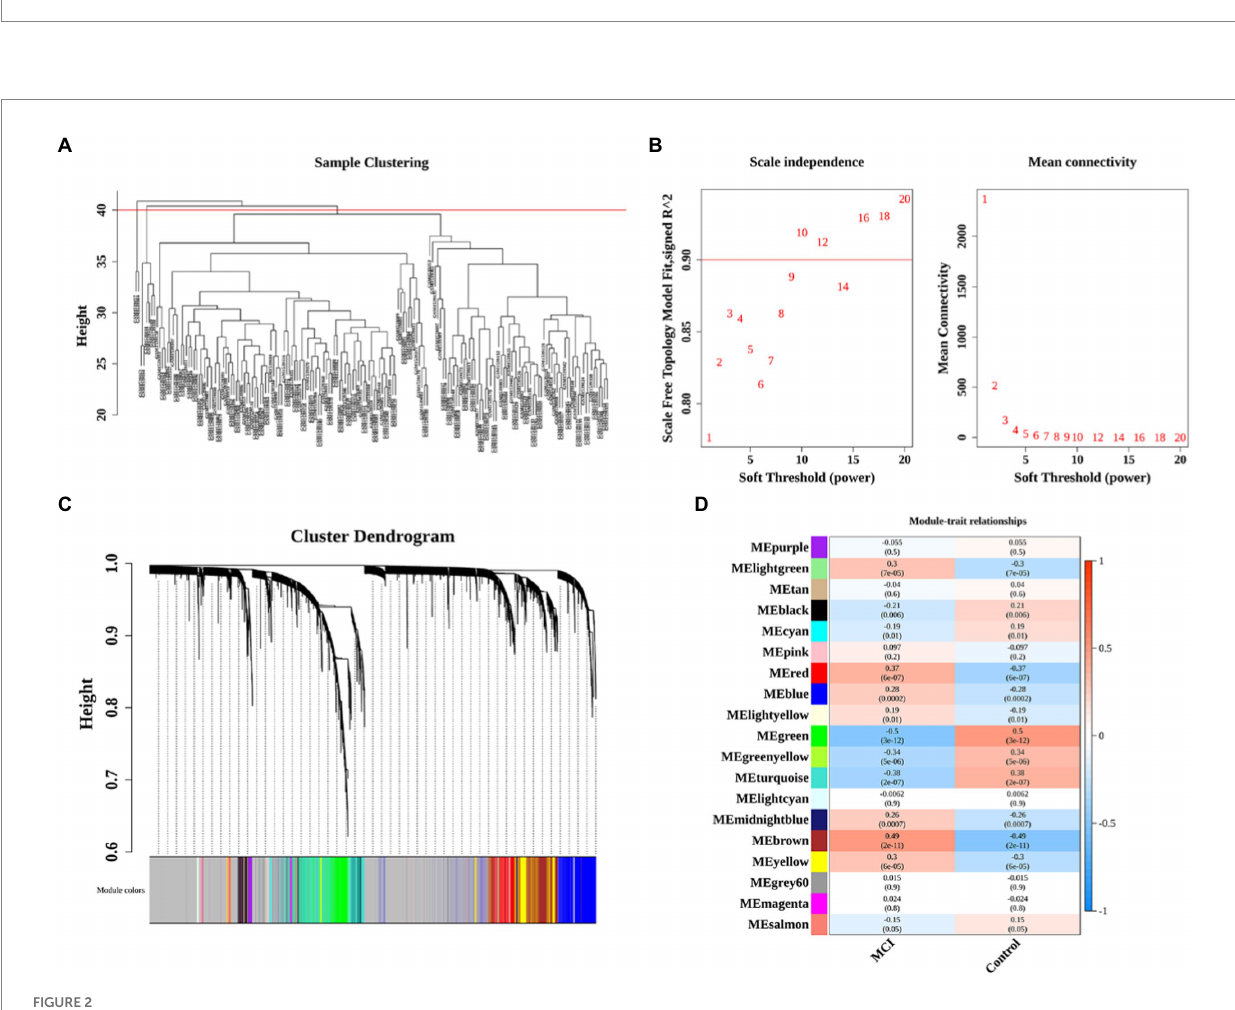
FIGURE 2 Identification of significant modules and genes of GSE63060 by WGCNA. (A) Clustering dendrogram of samples. (B) Network topology analysis with different soft thresholds. The scale-free R 2 was 0.90 and the soft threshold was 10. (C) A cluster dendrogram of module-specific colors showed 19 co-expressed gene modules between MCI and controls. (D) Heatmap of correlation between disease groupings and gene